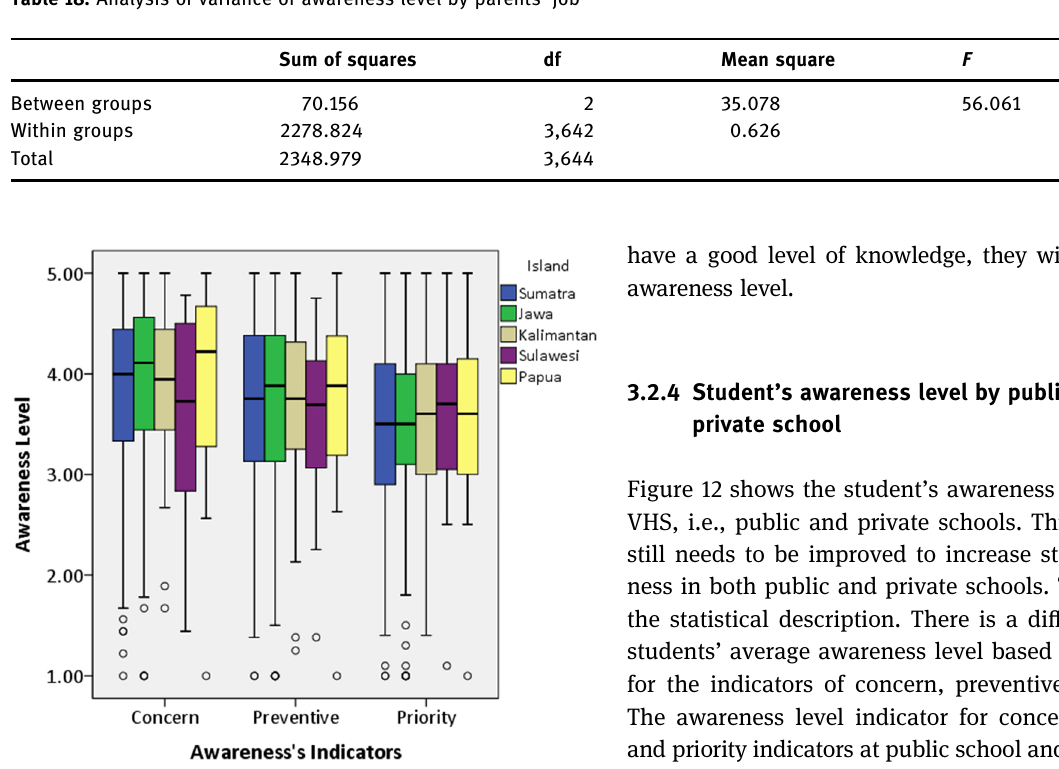
Figure 11: Student ’ s awareness level by island.